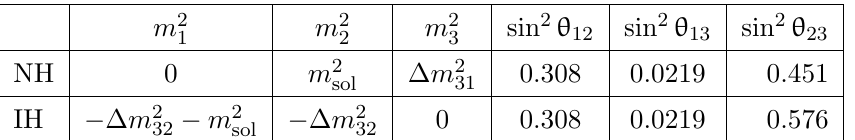
Table 1 . Best (cid:12)t values for the active neutrino masses m a and mixings (cid:18) ab for normal hierarchy (NH) in the top row and inverted hierarchy (IH) in the bottom row from ref. [68]. Note there is no detection of the Dirac phase (cid:14) at a signi(cid:12)cant level. For that reason (cid:14) remains an free parameter throughout this paper. The smaller measured mass di(cid:11)erence, the so-called solar mass di(cid:11)erence, is given by m 2 = m 2 (cid:0) m 2 = 7 : 49 (cid:2) 10 (cid:0) 5 eV 2 . The larger mass di(cid:11)erences are given by 2 1 sol (cid:1) m 2 = m 2 (cid:0) m 2 = 2 : 477 (cid:2) 10 (cid:0) 3 eV 2 for NH and (cid:1) m 2 = m 2 (cid:0) m 2 = (cid:0) 2 : 465 (cid:2) 10 (cid:0) 3 eV 2 < 0 31 3 1 32 3 2